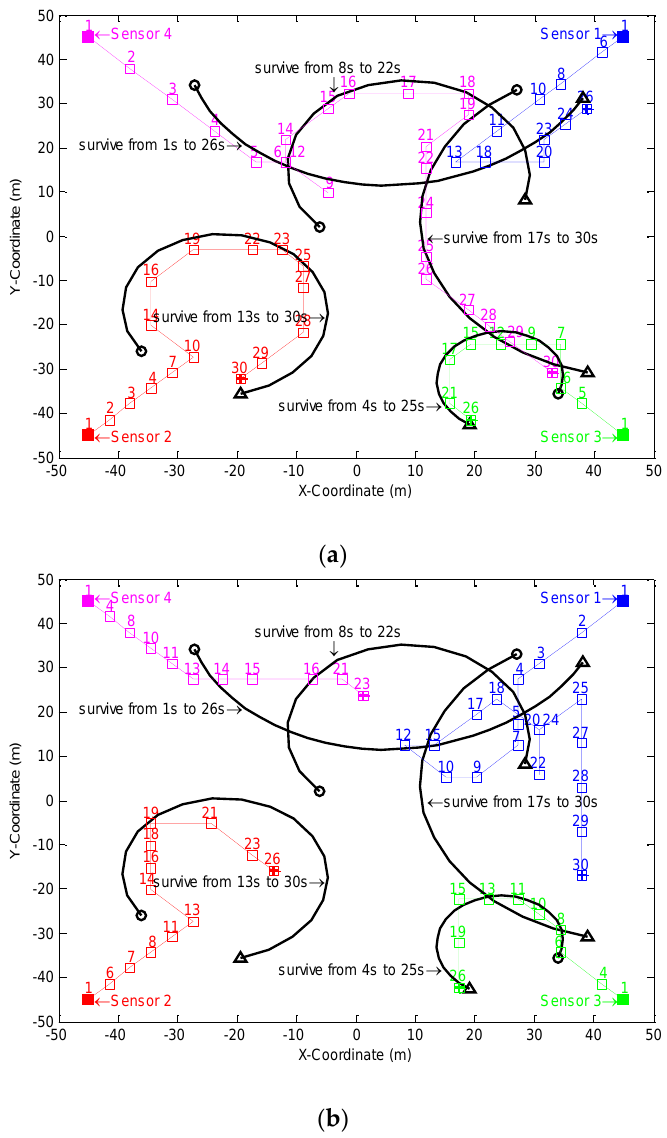
Figure 1. Sensor trajectories in a simulation by using ( a ) CS divergence with exhaustive search and ( b ) error bound with exhaustive search. The black line is the target trajectory, and ∆ are the target starting point and ending point respectively; The color line is the sensor trajectory, (cid:3) and the number above it are the sensor position and the time when the sensor is located at the position respectively, ■ and 田 are the sensor starting point and ending point respectively.